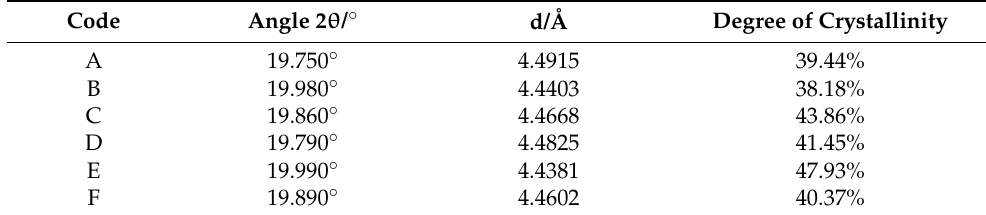
Table 2. Crystal properties of membrane by X-ray